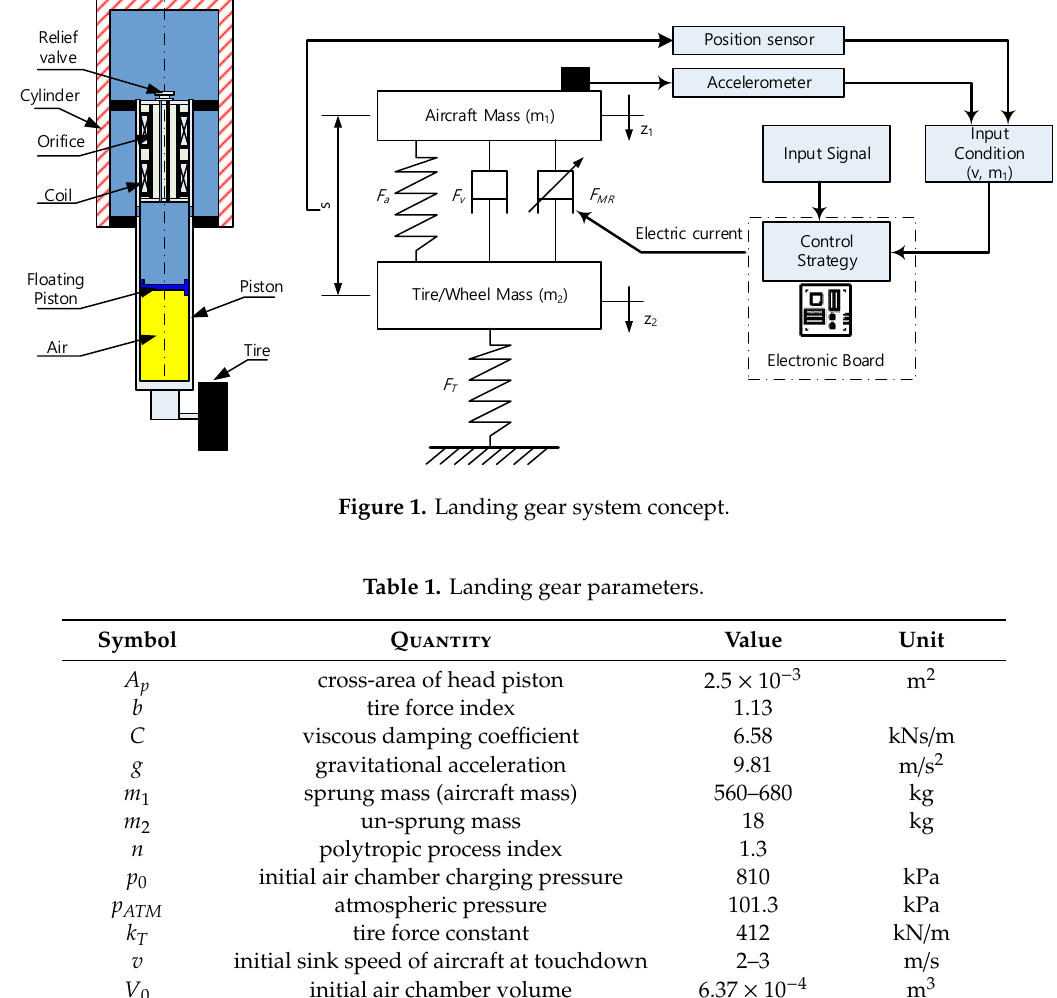
Table 1. Landing gear parameters.